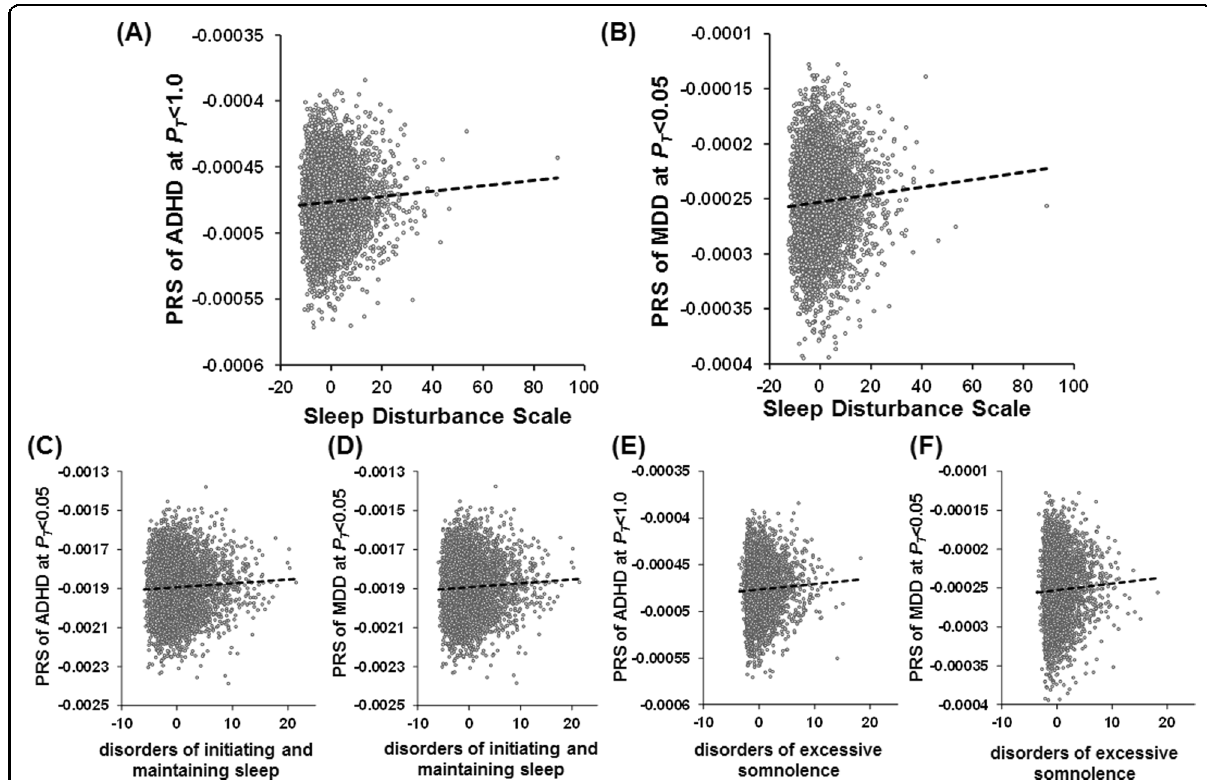
Fig. 2 Positive correlations between PRSs based on GWASs of ADHD and MDD. Positive correlations between PRSs based on GWASs of ADHD and MDD, and the total scale ( A , B ) and subscales ( C – F ) of childhood sleep disturbance in European children. Confounding factor-corrected total scores and subscale scores of the sleep disturbance scale are indicated. The PRSs for each psychiatric and neurodevelopmental disorder at P T cutoff with the most signi fi cant correlations with sleep disturbance are